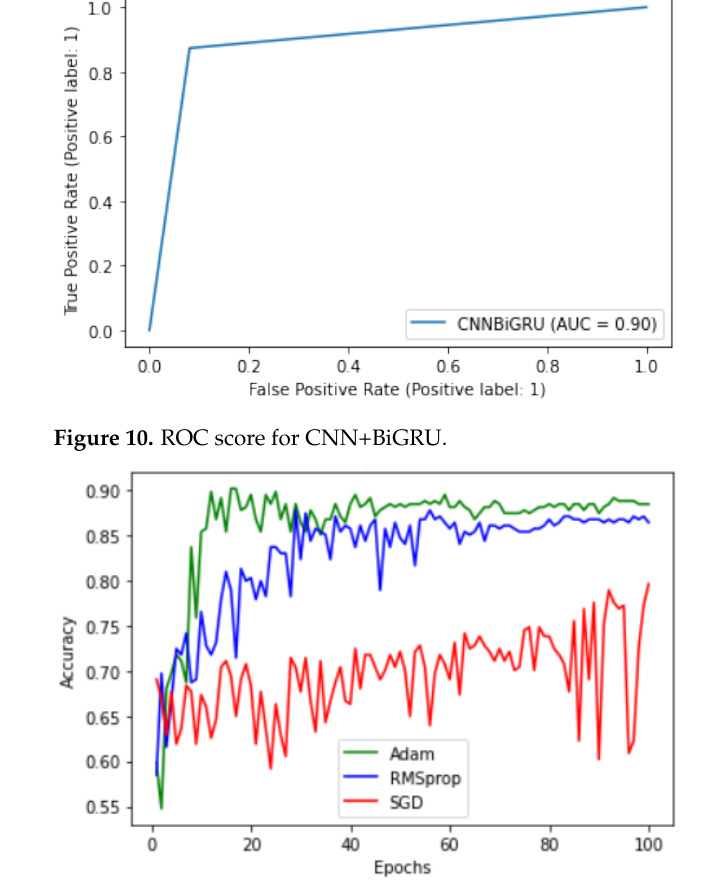
Figure 11. The model’s validation accuracy with different optimizers.